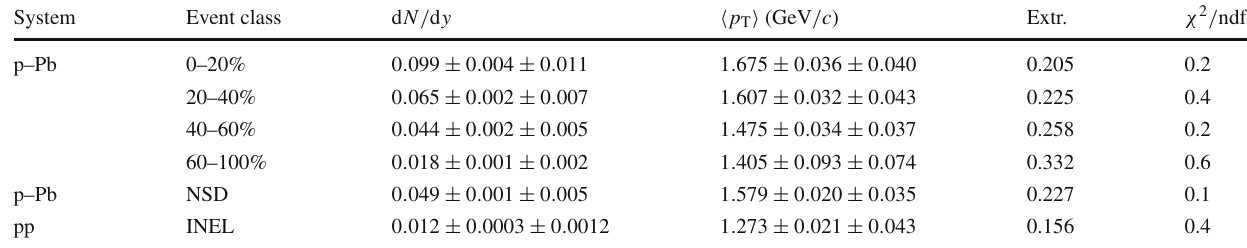
Table 3 d N / d y and (cid:6) p T (cid:7) along with the extrapolation fraction (Extr.) and χ 2 / ndf from the fit to the p T distribution. The values included in the table correspond to four multiplicity intervals (V0 estimator)